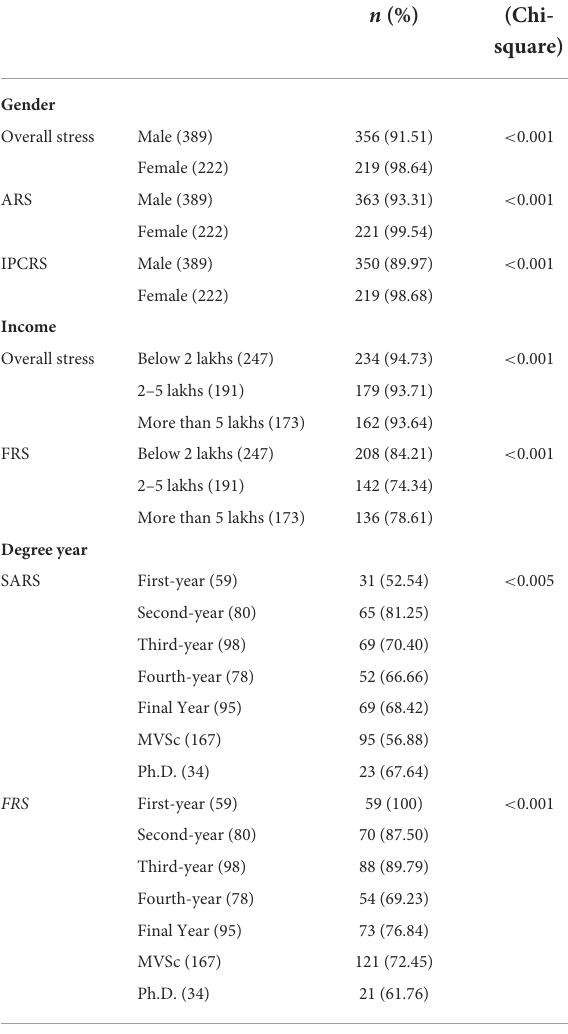
TABLE 6 Significant relation of gender, family income, and degree year with overall stress and individual factors. Variables